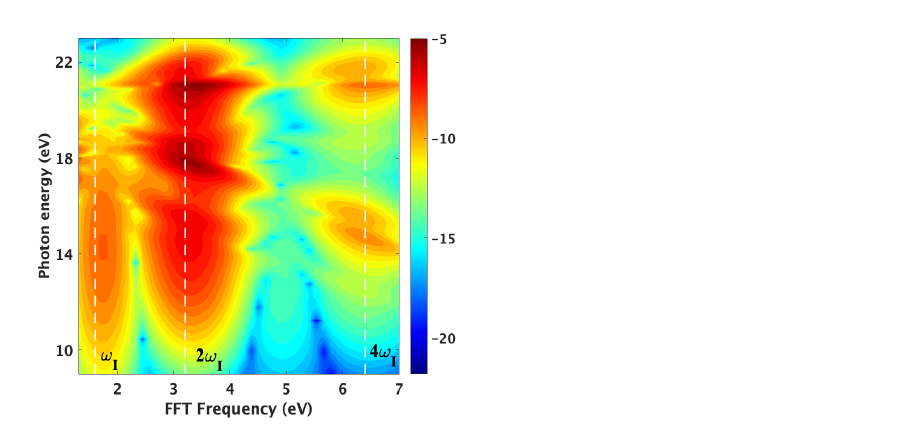
Figure 3. Fourier transformation of the absorption spectrum in Figure 1b along the delay axis. Figure 3 is the Fourier transformation along the delay axis for each XUV frequency.